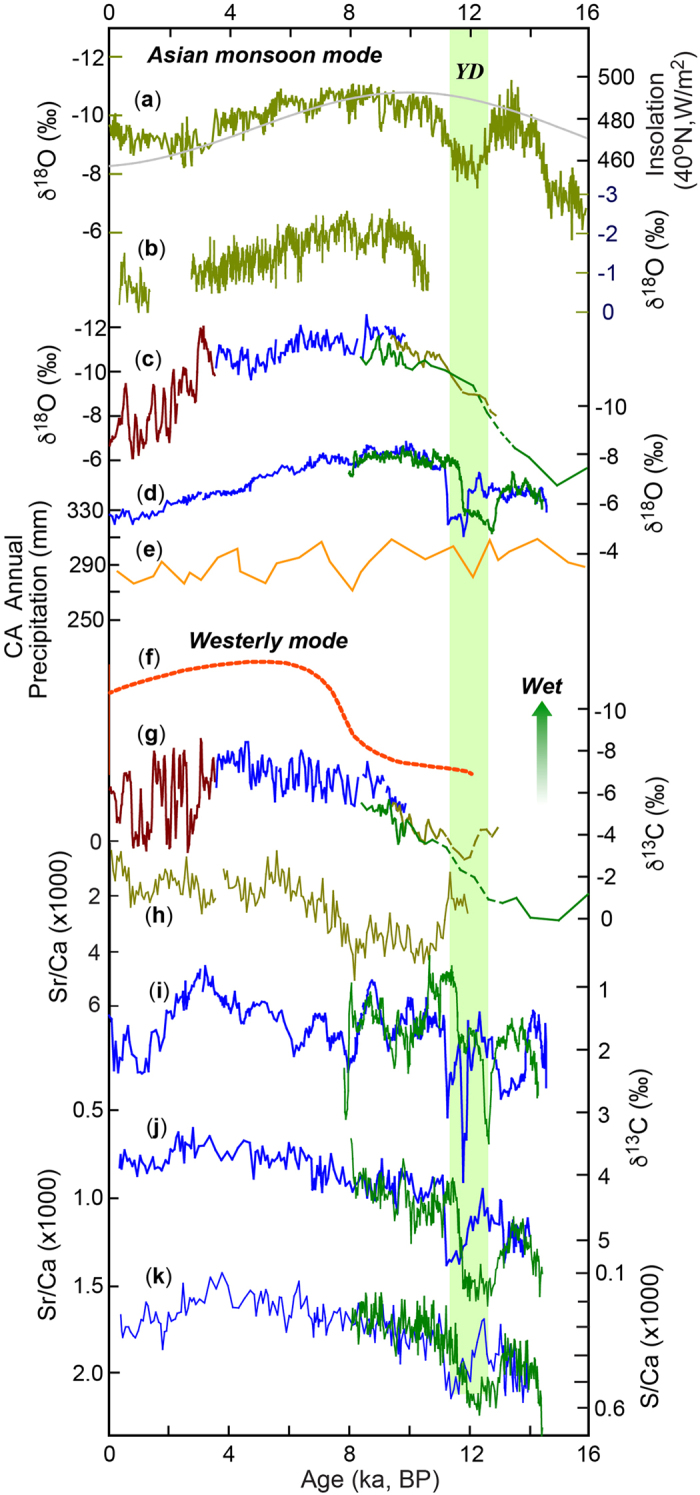
Holocene climate modes in CA.Two Holocene climate modes inferred from δ18O (supra-regional) and δ13C/trace element (cave area) records from Kesang and Ton caves, respectively. (a,b) Asian monsoon δ18O records (East Asian18 and Indian monsoon58, respectively). (c,d) CA δ18O records from Kesang9 and Ton (this study) caves, respectively. (e) Modeled annual precipitation in CA5. (f) The CA climate mode inferred mainly from lake records6. (g,h) Kesang δ13C and Sr/Ca records. (i–k) TON-1 (green) and TON-2 (blue) δ13C, Sr/Ca and S/Ca records, respectively. While the supra-regional hydroclimatic mode (c–e) is similar to the AM (a,b), the cave site hydrological mode (g–k) is consistent with the published lake records in the same region (f) with a phase lag of several ka to the supra-regional mode.